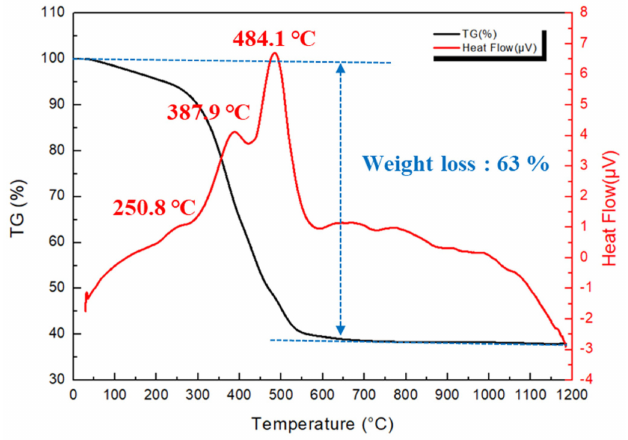
Figure 2. The TG-DSC curve of the ceramic green